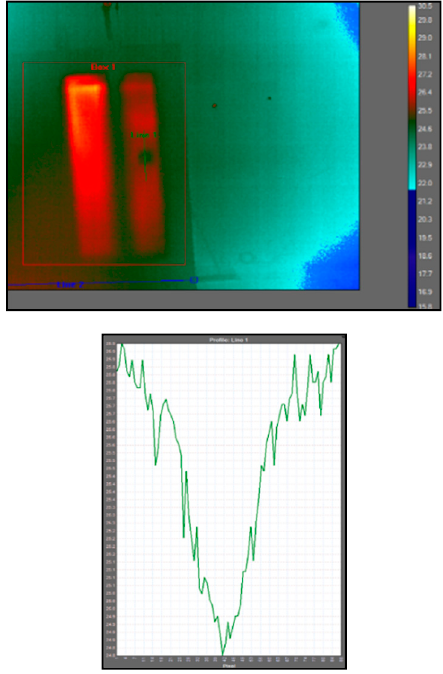
Figure 26. Using research IR with FLIR, the data could be further processed. The profile line displays the pixel contrast di ff erence where the “defect” is.